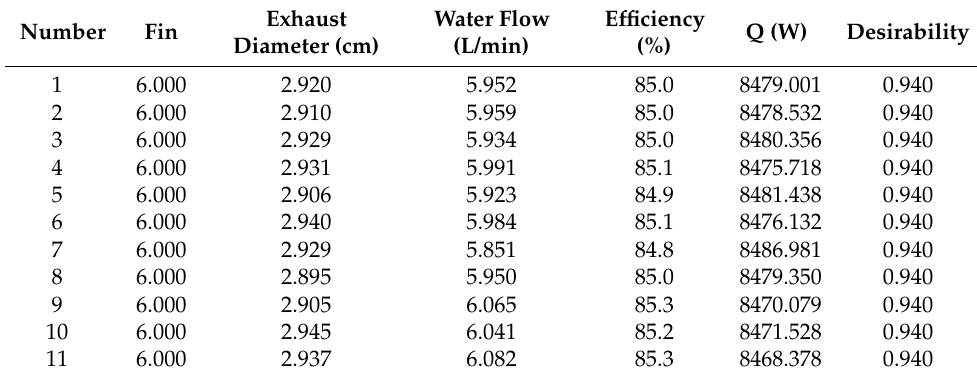
Figure 4. ( a ) Response surface representing HTR as a function of fin number and WFR, ( b ) contour lines representing HTR as a function of fin number and WFR, ( c ) response surface representing HTR as a function of fin number and exhaust outlet diameter, and ( d ) contour lines representing HTR as a function of fin number and exhaust outlet diameter. Table 8. Results of optimizing the efficiency and HTR of STHE using